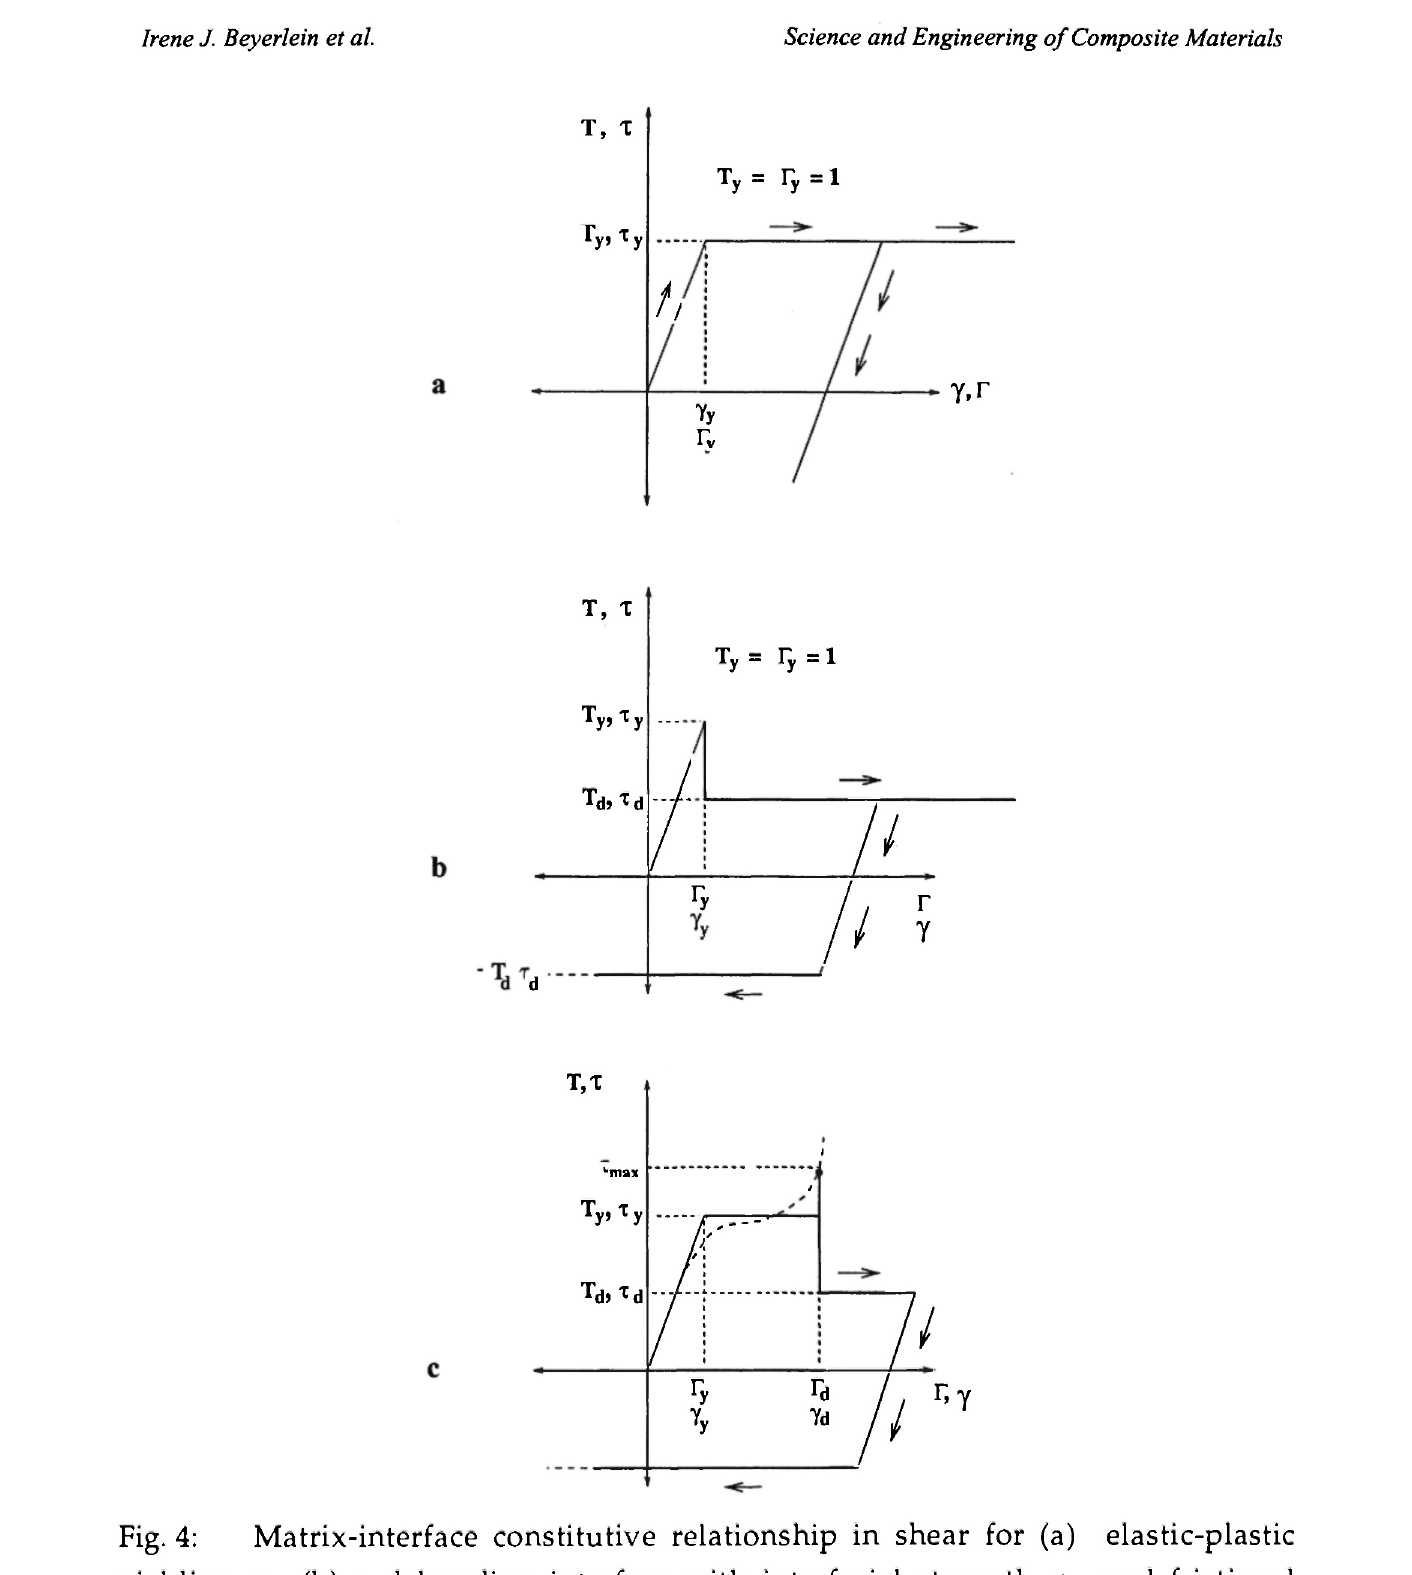
and frictional y , Γ,*, T , y y